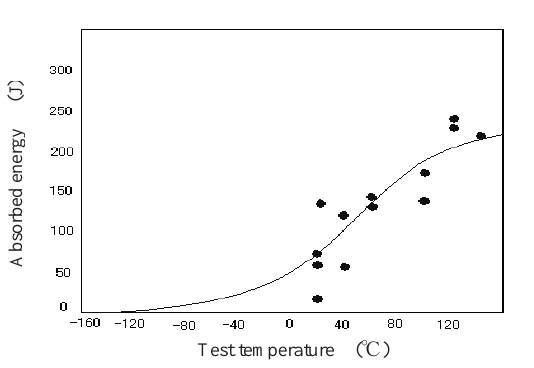
Test temperature ( (cid:864) ) Fig.2. Transition curve of Charpy absorbed energy for PWHT (post-weld heat treated) material. (0 (cid:864) is 273 K).